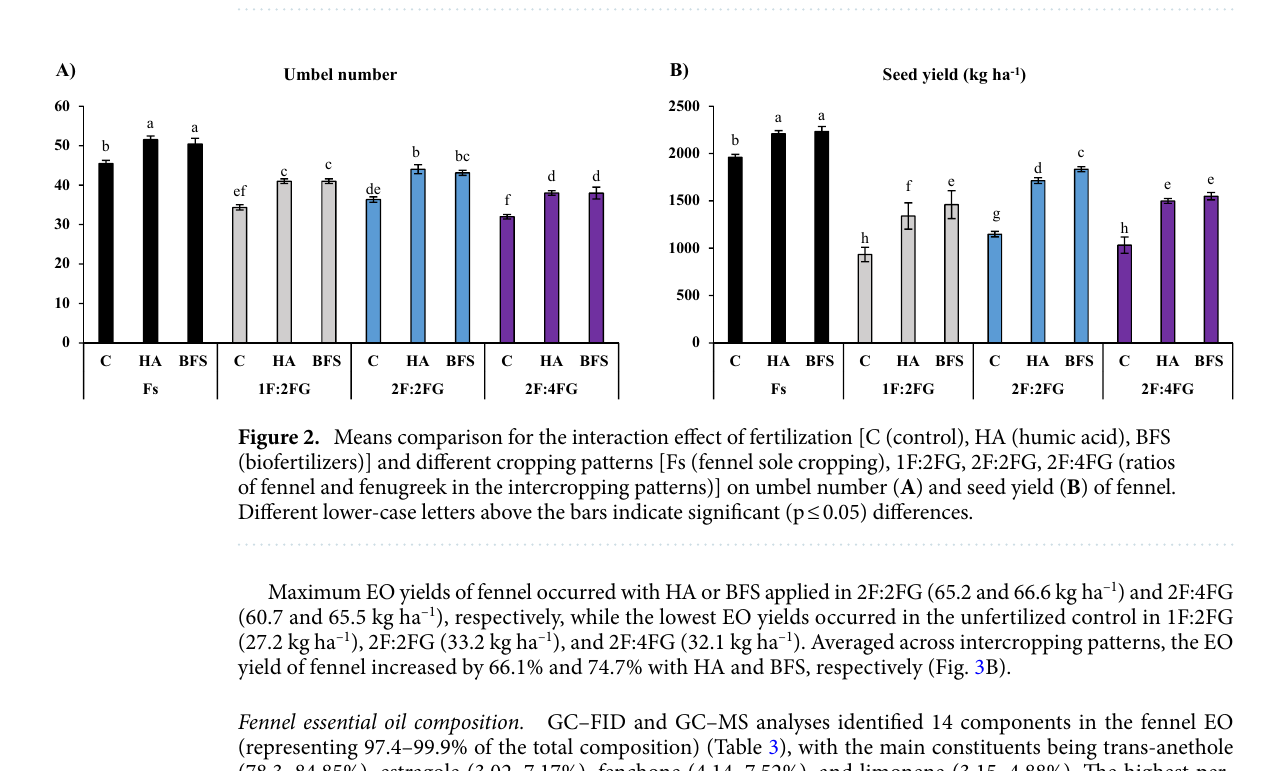
Figure 1. Means comparison for the main effects of cropping patterns [Fs (fennel sole cropping), 1F:2FG, 2F:2FG, 2F:4FG (ratios of fennel and fenugreek in the intercropping patterns)] on plant height ( A ), and fertilization [C (control), HA (humic acid), BFS (biofertilizers)] on plant height ( B ) and 1000-seed weight ( C ) of fennel. Different lower-case letters above the bars indicate significant (p ≤ 0.05) differences.